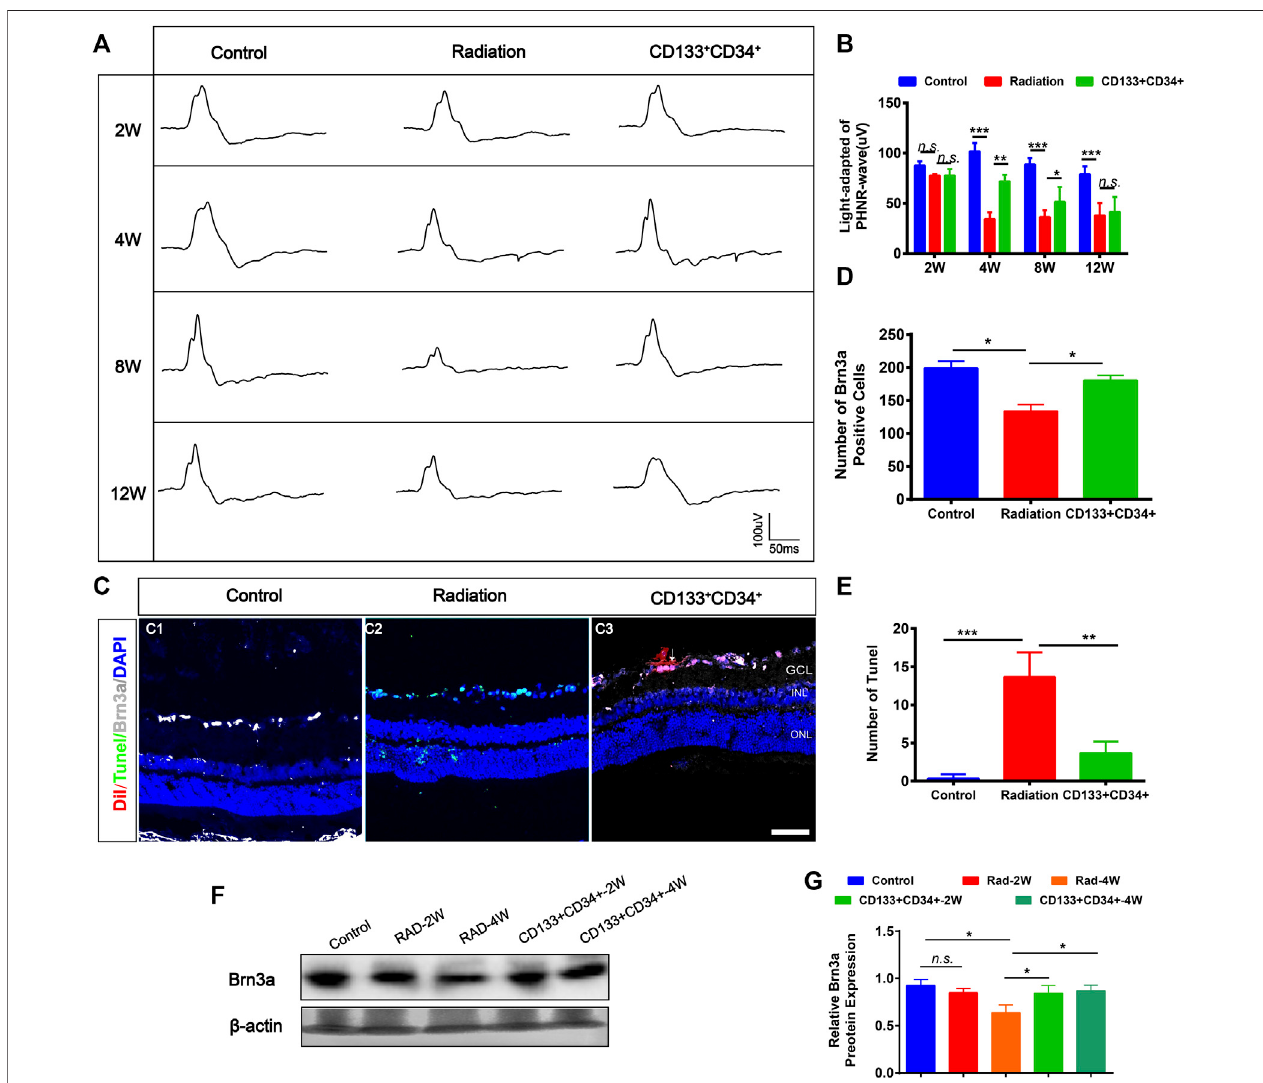
FIGURE 5 | Transplanted CD133 + CD34 + cells rescued radiation injured RGCs of LE rats. (A) : Representative images of light-adapted of PHNR-wave on control, irradiated,andtransplantedgroupaftertransplantation2,4,8,and12 weeks. (B) :ThestatisticsofPHNR-waveonfourtimepoints. (C) :RepresentativeimagesofBrn3a + ganglion cells (Gray) and Tunel (Green) staining on the retina from control, irradiated, and transplanted group at transplantation 4 weeks. Scale bar: 50 μ m. (D – E) : The statistics of the numbers of Brn3a and apoptotic positive cells in the retina. (F) : WB analysis of the Brn3a protein expression. (G) : The statistics of relative Brn3a protein expression in WB analysis. N = 3. Data are depicted as means ± SEM. (* p < 0.05, *** p < 0.01, *** p < 0.001, ANOVA-test). GCL: ganglion cell layer; INL: inner nuclear layer; ONL: outer nuclear layer.